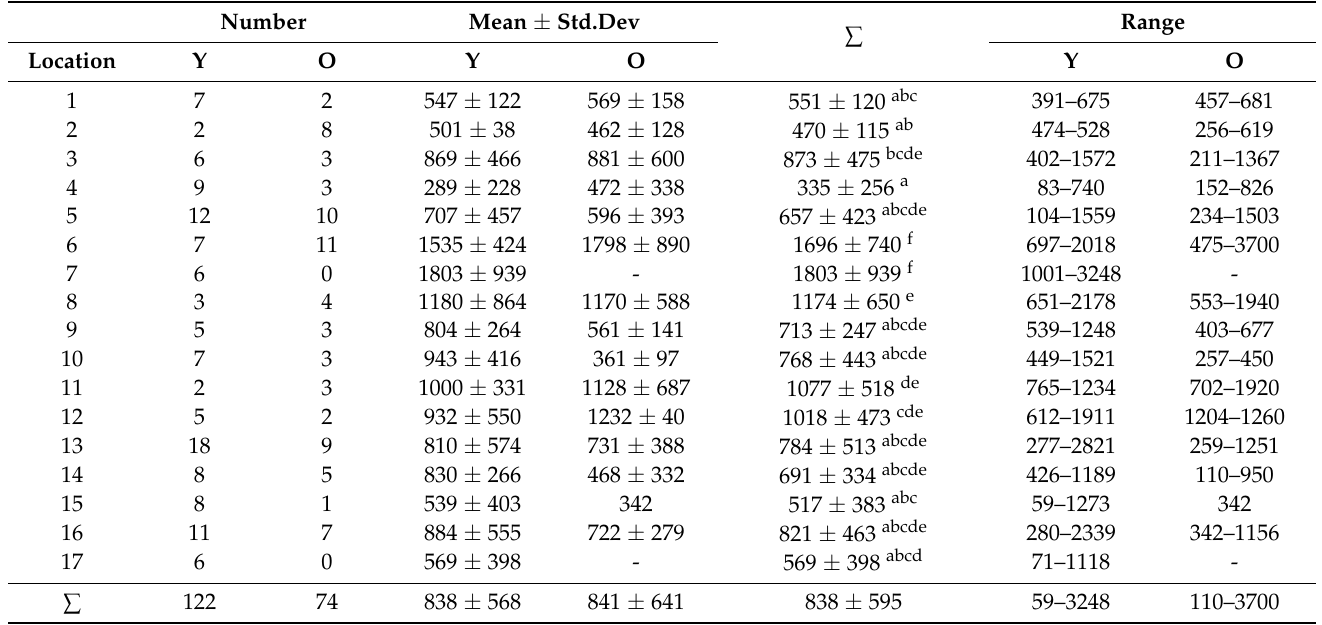
Table 1. The occurrence of lead in samples of hare liver from 17 different locations in the region of Vojvodina ( µ g/kg of fresh weight), ppb.